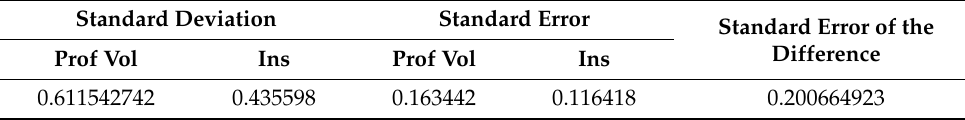
Table 2. Deviation and error of the profit volume of banks and insurances premiums. Standard Deviation